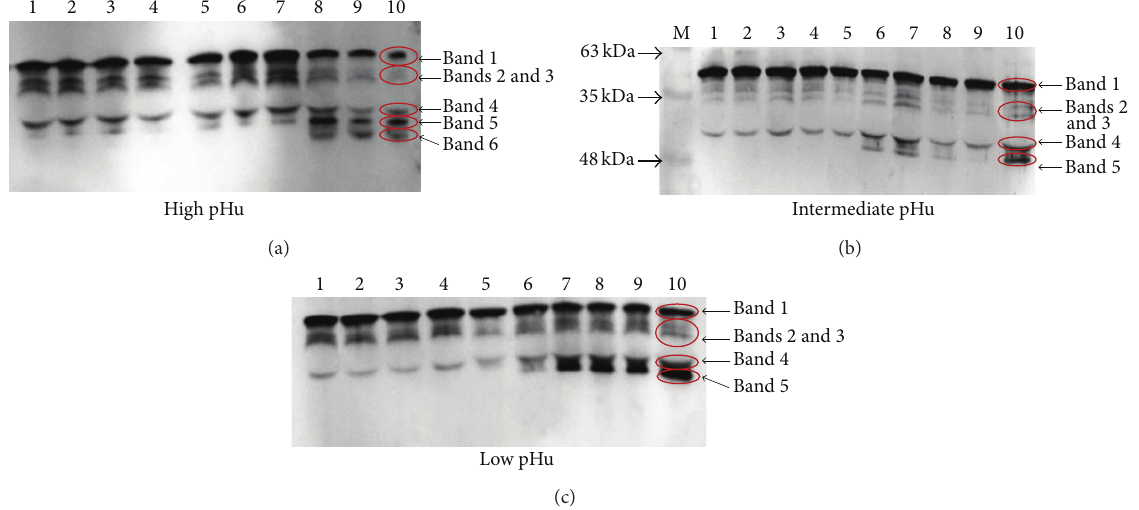
Figure 3: Representative Western blot of desmin and degradation products. Each lane was loaded with 40 𝜇 g of protein. M is the molecular weight marker. Lanes 1 to 10 represent the variability in desmin degradation from high, intermediate, and low pHu beef held at 4 ∘ C for 0.5 h, 3 h, 6h, 12 h, 24h, 2 d, 3 d, 5d, 7d, and 9 d postmortem. Band 1 = 54kDa, Bands 2 and 3 = 50 and 47 kDa, Band 4 = 41 kDa, Band 5 = 39 kDa, and Band 6 = 34 kDa.